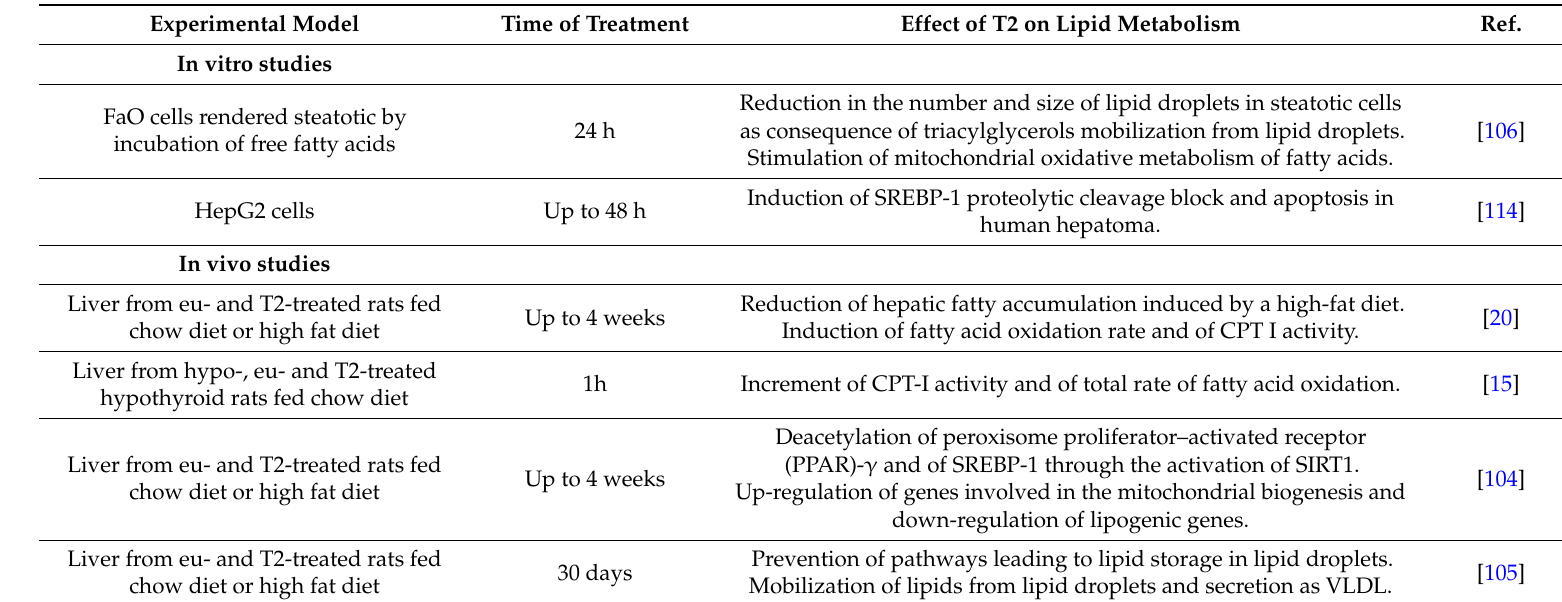
Table 2. Relevant effects of T2 on hepatic fatty acid